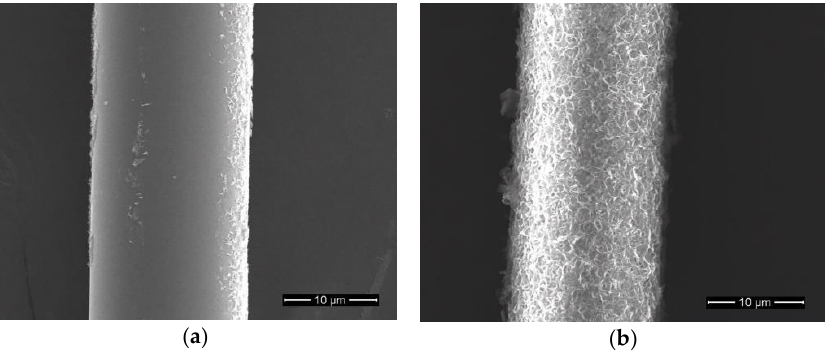
Figure 6. SEM images of basalt fibers immersed in 1 mol/L NaOH solution for 3 days: ( a ) 25 °C; ( b ) 50 °C.